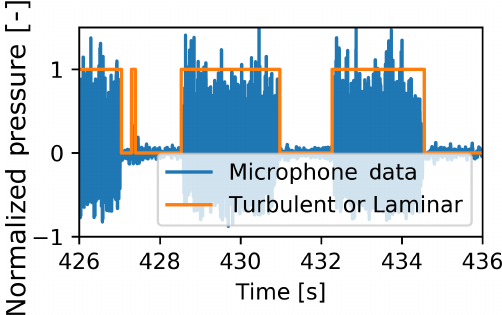
Figure 7. Identification of a boundary layer state using a recur- rent neural network (data from Bak et al., 2010) (see code exam- ple https://github.com/MatthewLennie/Aerodynamics, last access: 13 September